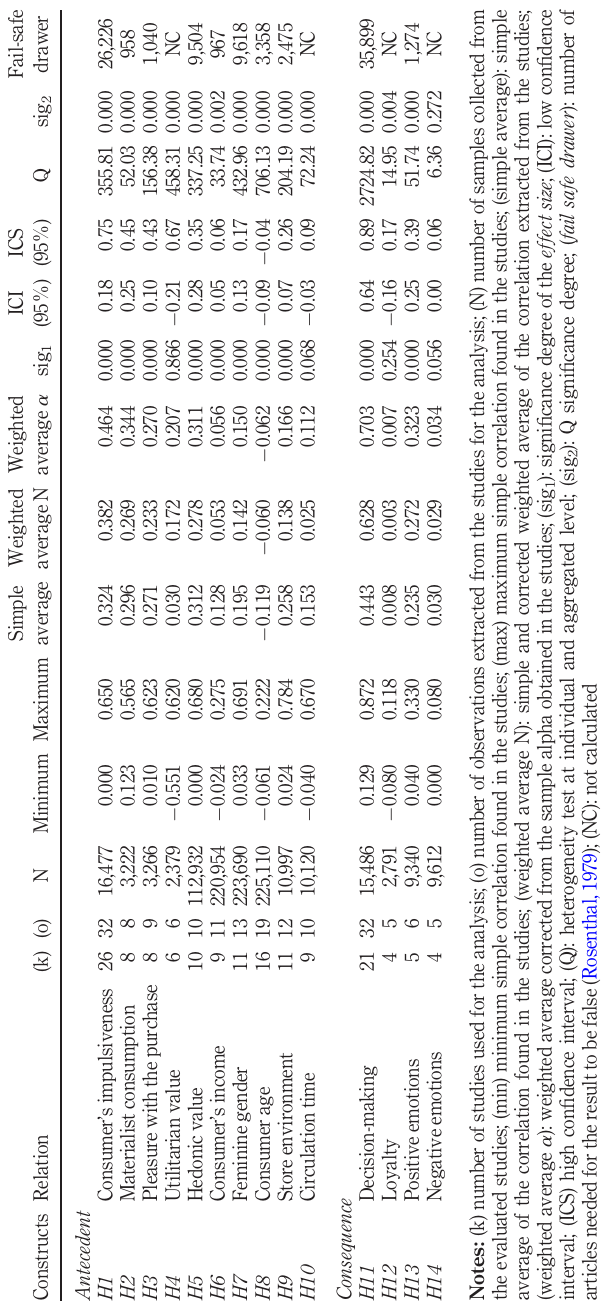
Table II. Meta-Analysis